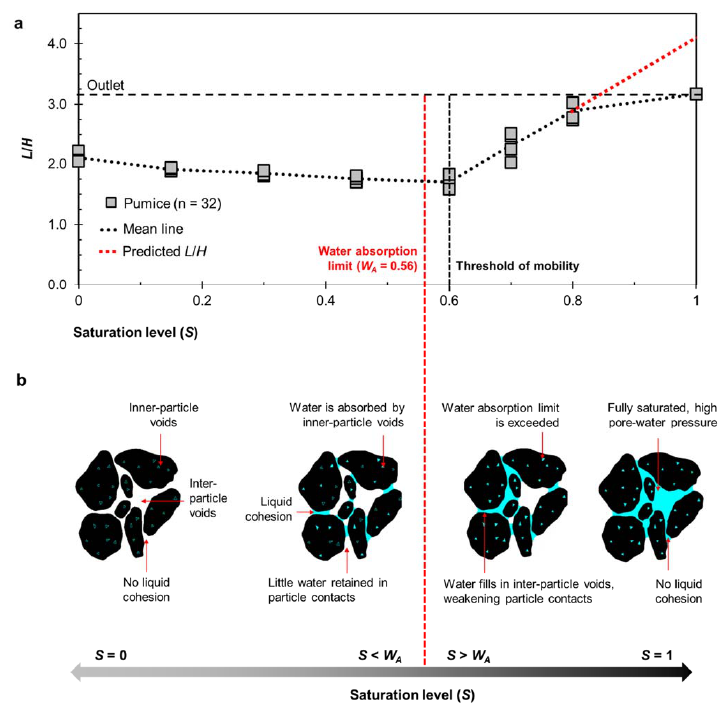
Figure 6. ( a ) Effects of inner ‐ particle water absorption ( W A ) on pumice mobility. X ‐ axis shows sat ‐ uration levels ( S ), where S = 0 represents completely dry conditions and S = 1 represents com ‐ pletely saturated conditions. Y ‐ axis shows L / H , representing the ratio between total travel distance ( L , cm) and total drop height ( H , cm) of sediment. ( b ) Schematic illustration of possible soil ‐ water interactions on pumice. Water absorption limit ( W A , %) is converted to the saturation level ( S ) by dividing W A (%) by the saturated water content ( w Sr , %).